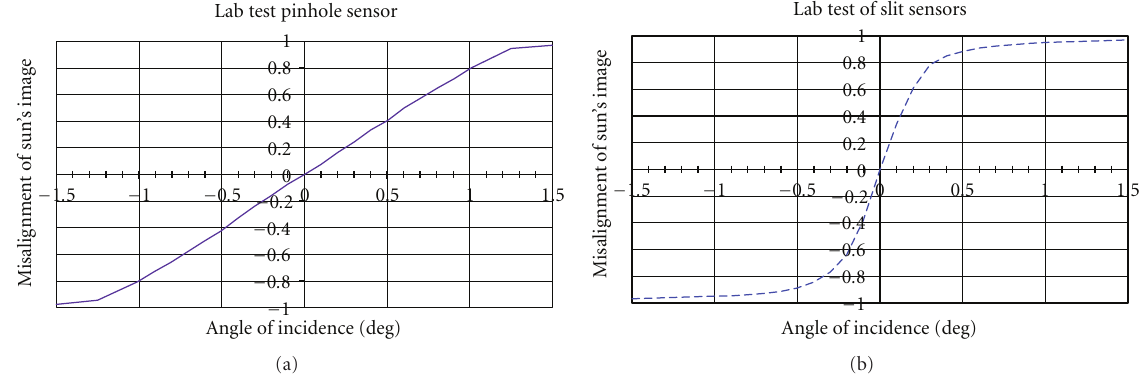
Figure 10: (a) Results for Pinhole Sensor. (b) Results for Slit Sensor.